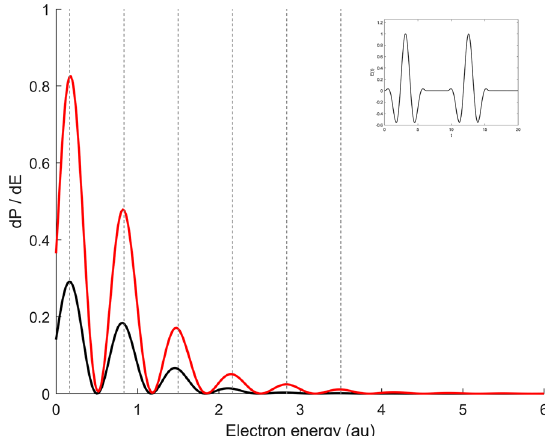
Figure 7. Ionization spektrum of H after irradiation with two delayed pulses according to (31). The electric field of the pulse is depicted in the inlay with N 1 different field amplitudes: black curve: E 0 maxima predicted by